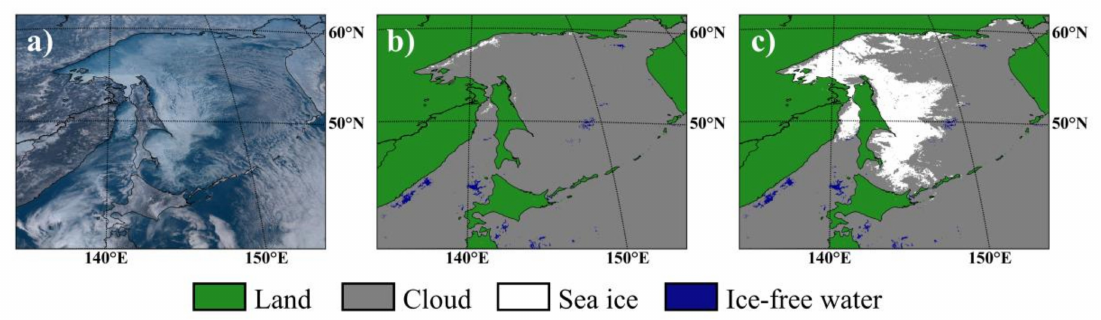
Figure 9. ( a ) Himawari-8 / AHI RGB image (WSDbank); ( b ) sea-ice data map image using GK-2A / AMI sea-ice detection algorithm without cloud recheck; and ( c ) after cloud recheck at 0330 UTC